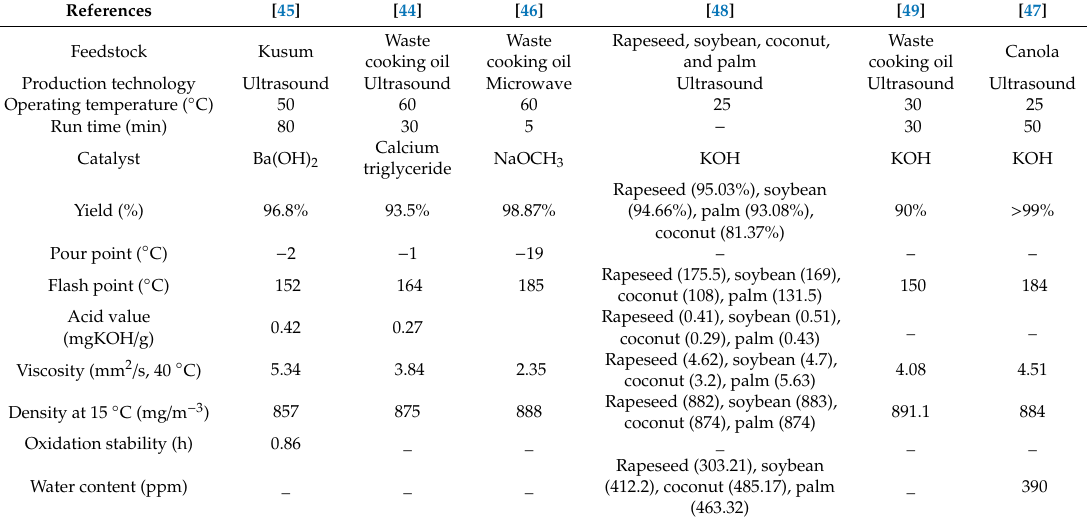
Table A1. Biodiesel production technology and properties of